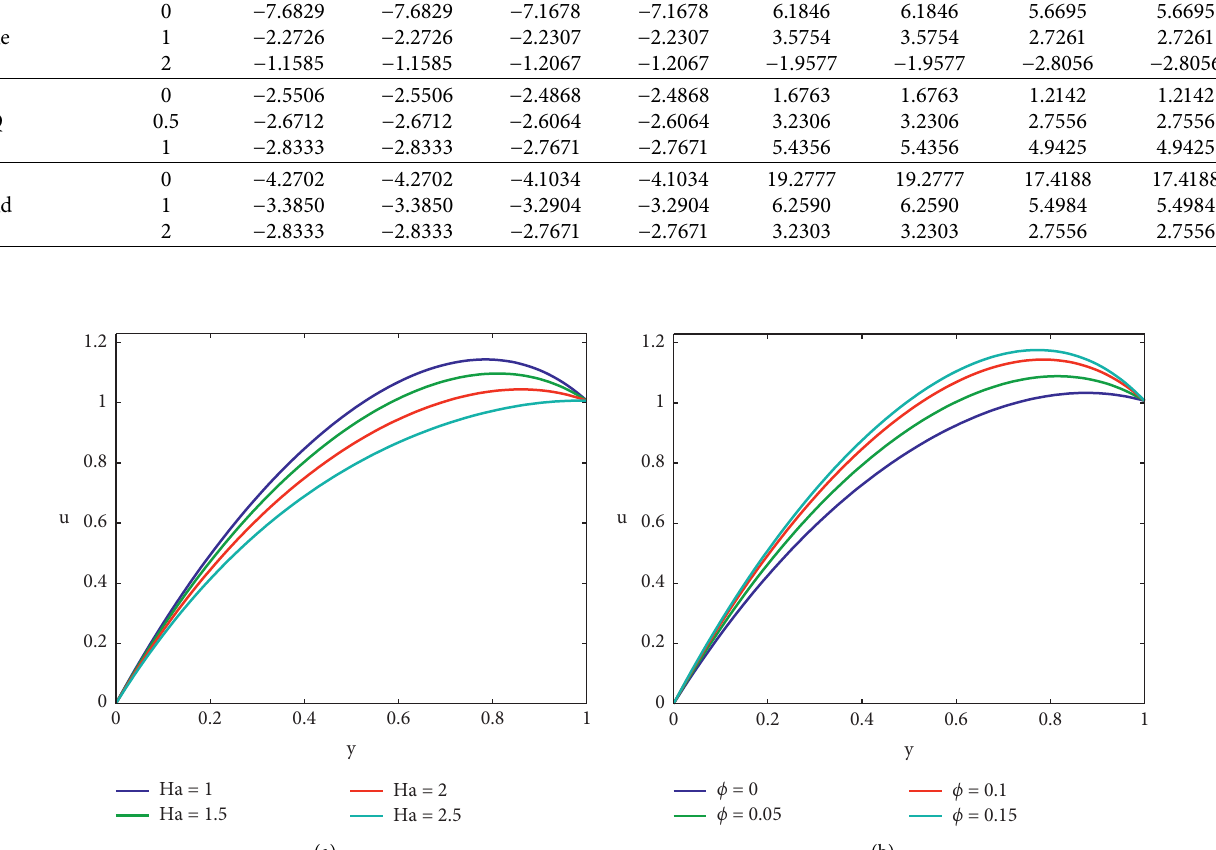
Figure 2: (a) Effect of Ha on the “velocity distribution” when φ � 0 . 1. (b) Effect of φ on the “velocity distribution” when Ha �